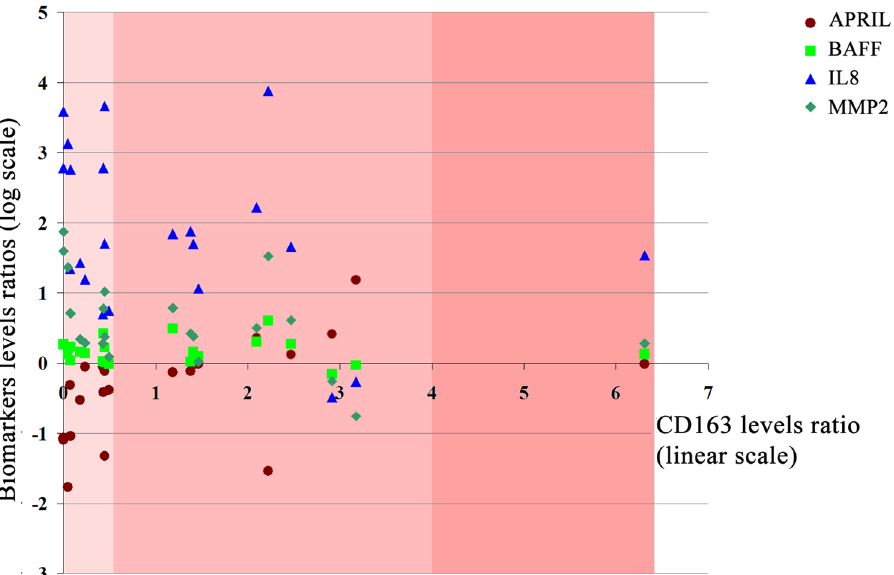
Figure 5. Plot of APRIL, BAFF, IL8 and MMP2 ratios (tumor/normal tissue) in log scale versus the CD163 ratios (tumor/normal tissue). Linear trend lines sharing the same color as the data points have been represented for each data set. The scatter plot chart area has been divided into three regions corresponding to the CD163 ratios 0.001–0.5, 0.5–4.0 and 4.0–6.0, with increasing red color intensity corresponding to the immune infiltrate observed in the histopathology reports: reduced, moderate and